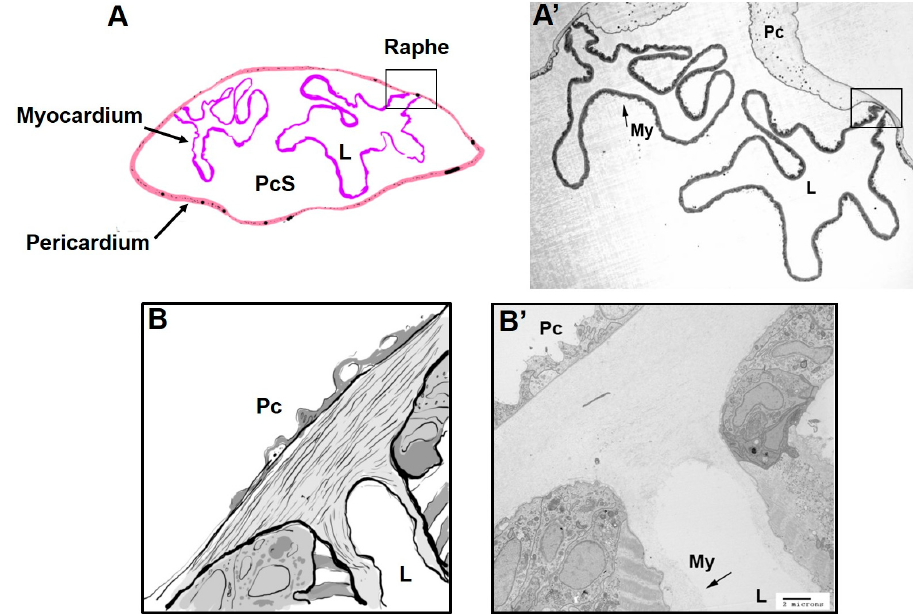
Figure 3. Relationship between the pericardium and the myocardium. ( A ) Cartoon representation of transverse section of adult Ciona heart imaged by TEM in A’ . The myocardial tube forms a lumen (L) that is surrounded by the pericardial space (PcS). The pericardium (Pc) joins the myocardium (My) at the raphe (boxed region in A and A’ ); and ( B ) cartoon representation of raphe as imaged by TEM in B’ . Between the cells of the outer pericardium and myocardium, the space is filled with an extracellular matrix that continues into the lumen of the myocardium (arrow, B’ ). Transitional cardiac myocytes exist where the inner layer of the pericardium transitions to the myocardium. Scale bar = 2 microns.